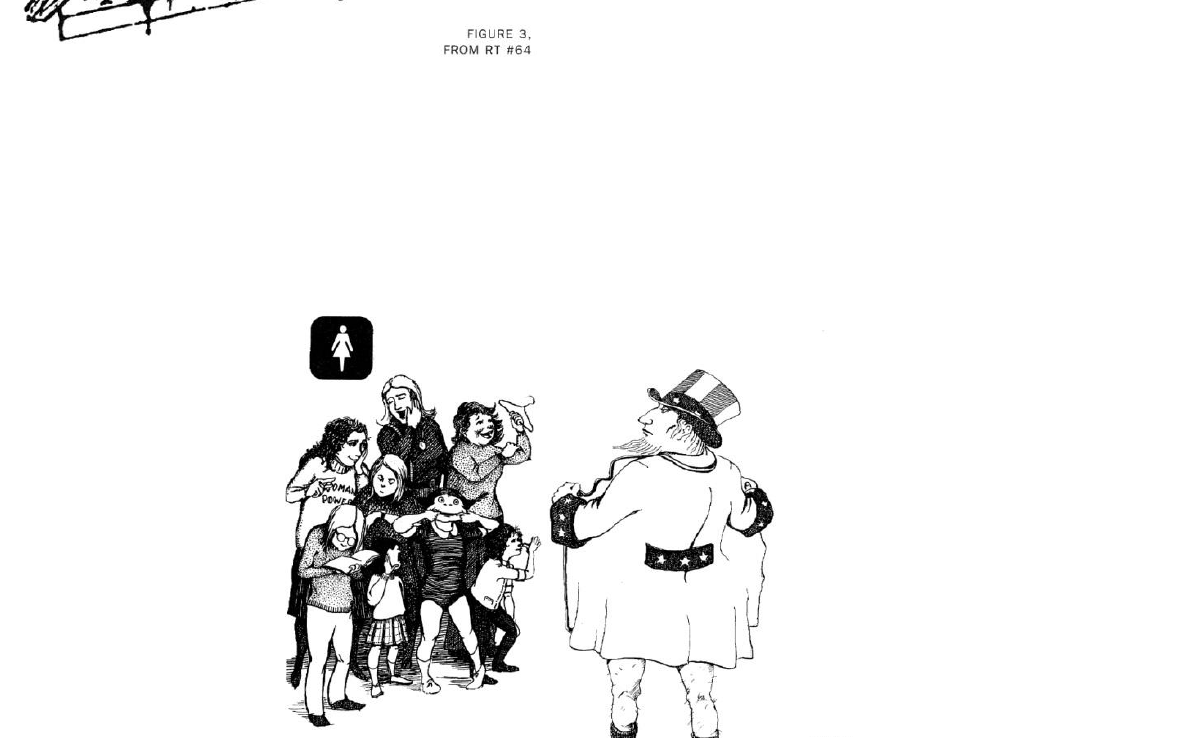
FIGURE 4. FROM RT